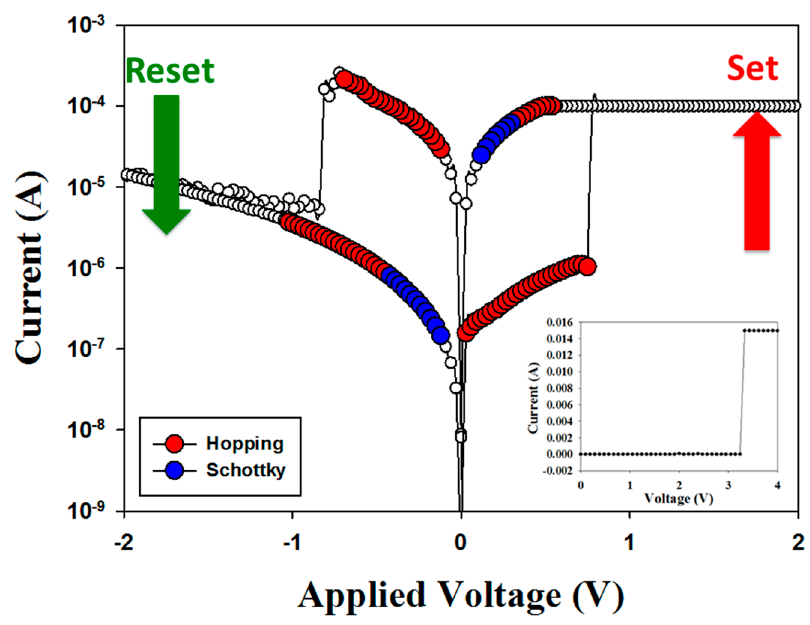
Figure 6. Bipolar switching properties of a BPFMO/BGTWO bilayer thin film.